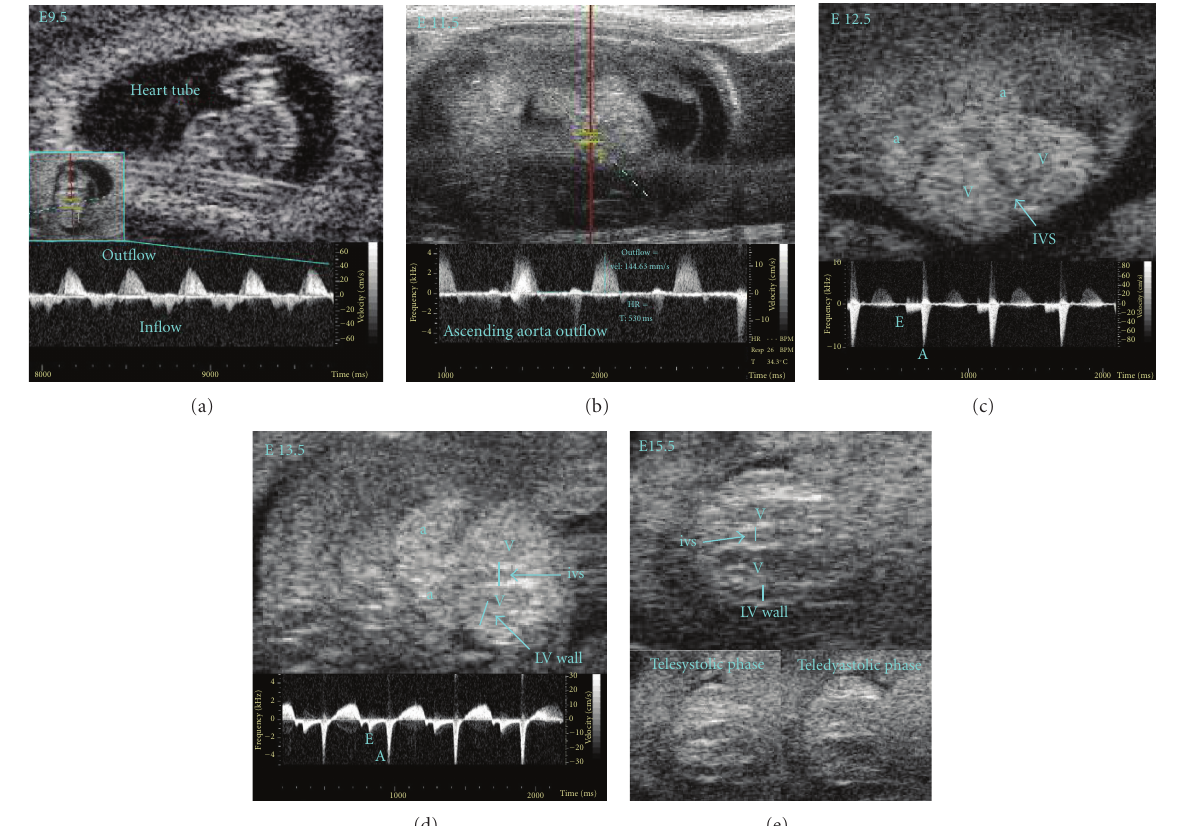
Figure 10: (a) E9.5: heart tube and doppler spectral trace of ventricular inflow and outflow at 9.5 gestational age. (b) E11.5: doppler spectral trace of ascending aorta outflow at 11.5 gestational age. (c) E12.5: bidimensional image of atrio-ventricular chambers (a–V) interventricular septum (IVS); and doppler spectral trace of ascending aorta outflow at 12.5 gestational age. (d) E13.5: bidimensional image of atrioventricular chambers, interventricular septum, and left ventricle wall (LV wall); doppler spectral trace of ventricular inflow and outflow at 13.5 gestational age. The atrial wave (A-wave) was dominant. The rapid ventricular filling (E-wave) is a measure of ventricular compliance. (e) E15.5: bidimensional image of ventricular chambers, interventricular septum, and left ventricle wall in telesystolic and telediastolic fase of heart cycle in a 15.5 days mouse